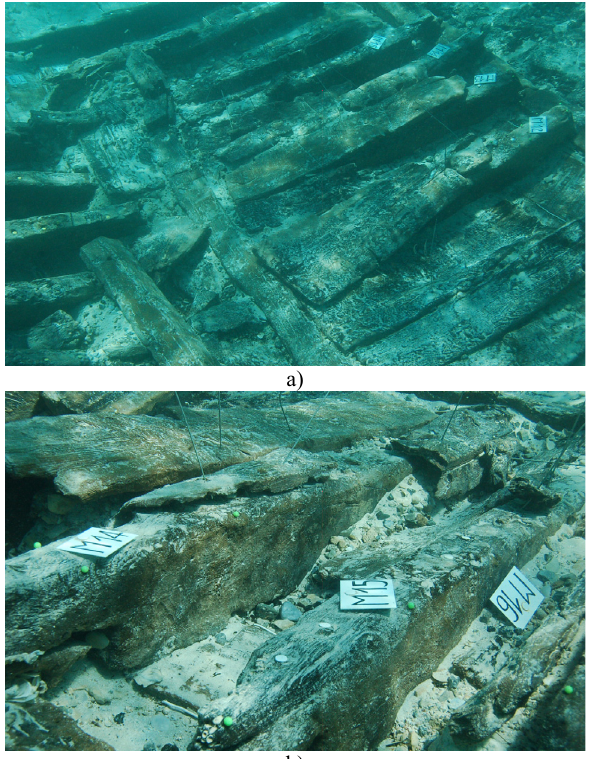
Figure 13. Imaging campaign performed at shallow depth: a) wide view shot, b) close-up showing a clearer picture of the wooden elements. Some thumb tacks “push-pin” and plastic cards used for markings.